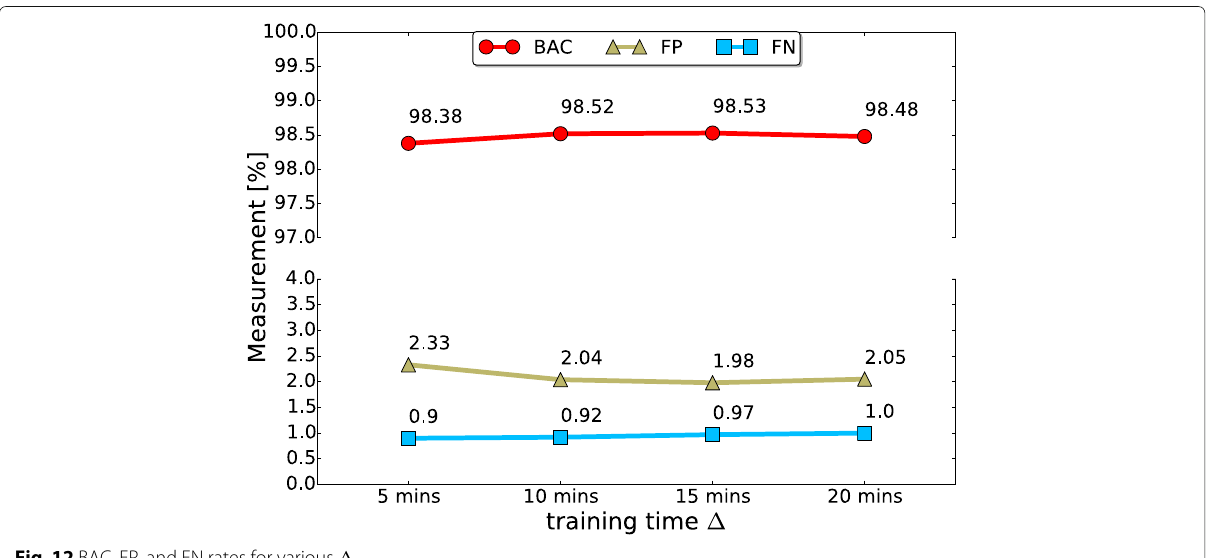
Fig. 12 BAC, FP, and FN rates for various (cid:2)